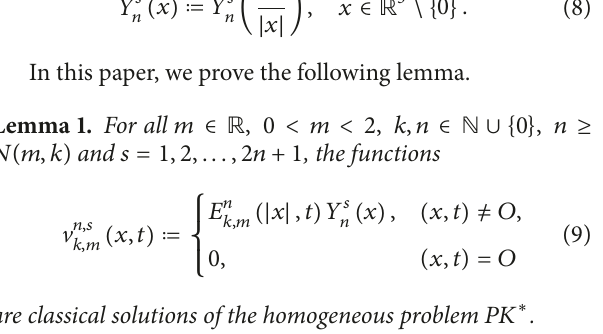
Figure 1: Region Ω 𝑚